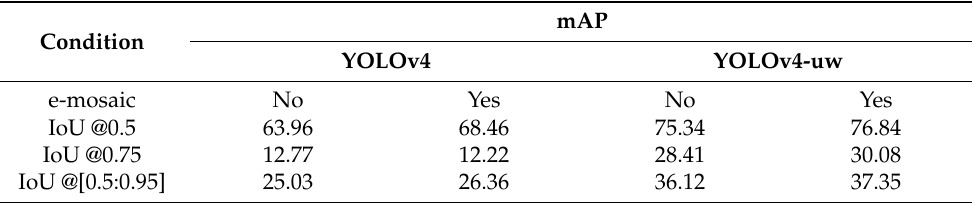
Table 5. Comparison of YOLOv4 and YOLOv4-uw, with and without e-mosaic. Condition